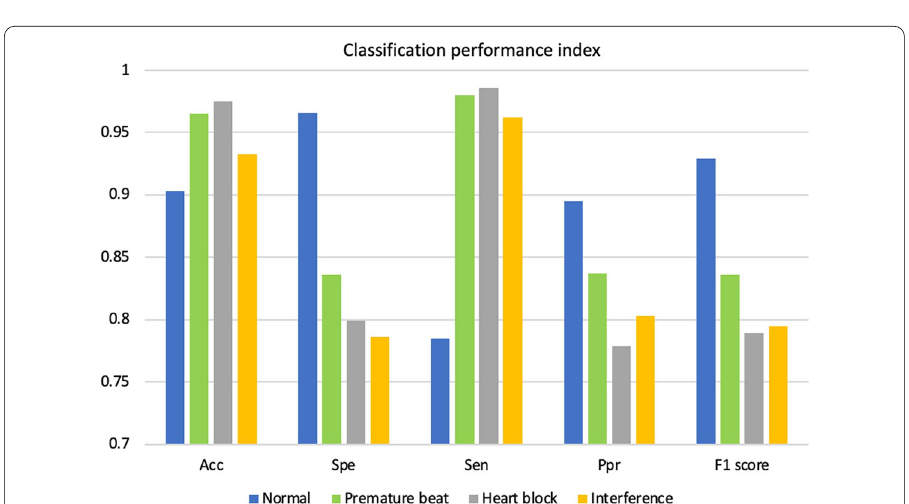
Fig. 9 The loss function curve of D-CNN model